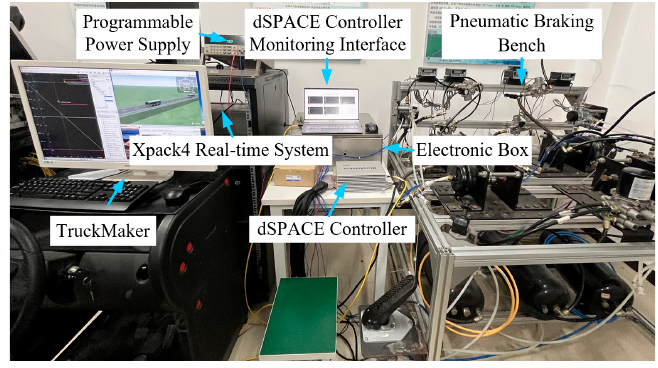
Figure 8. Verification system.